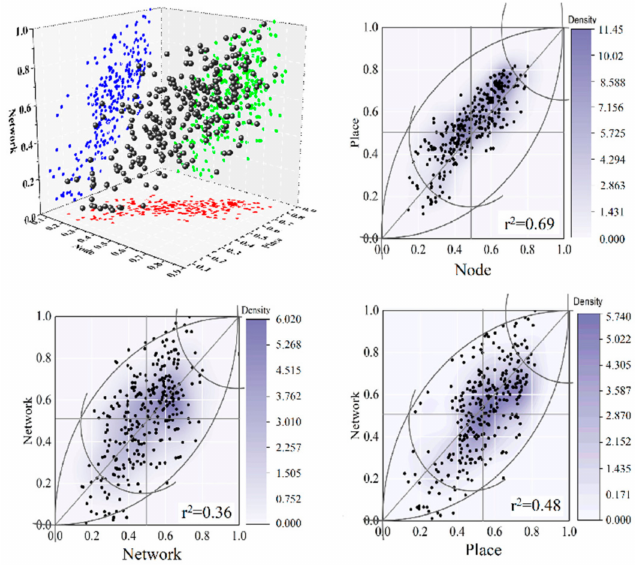
Figure 6. Node, place, and network indexes of the metro